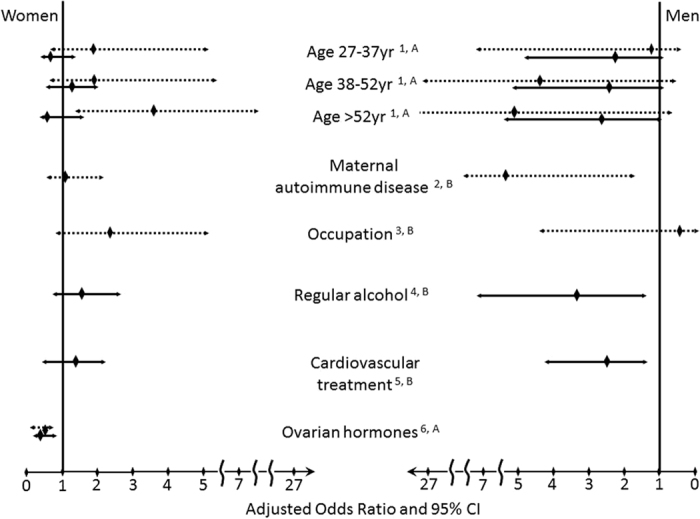
Risk factors for autoantibodies detected in men and women.Autoantibodies against thyroid peroxidase (anti-TPO, dashed line) and any tissue non-specific autoantibody (solid line) groups are shown separately. The tissue non-specific autoantibody group comprised individuals who tested positive for at least one of the 5 tested tissue non-specific autoantibodies. 1age groups were formed according to the values of 1st and 3rd quantiles and the median age compared to the youngest group (18–26 years); 2the presence of maternal autoimmune disease compared to individuals without maternal autoimmune disease; 3individuals with an occupational status of unemployed but being covered by pension insurance (includes retired individuals and unemployed individuals with insurance for disability) compared to employed persons; 4seldom but regular alcohol consumption (once a month) compared to non-consumers; 5the need for cardiovascular treatment on a regular basis at least 2 months prior to the study; 6women with active ovarian hormones includes women who menstruate and women with primary or secondary amenorrhea who receive hormone replacement therapy compared to women in menopause. Association values are given as odds ratios considered for multiple comparisons from multivariate logistic regression models stratified by gender and adjusted for the following confounders selected from Table 5: A age groups; B age groups (or ovarian hormonal activity in women), maternal autoimmune disease, occupational status, alcohol consumption, cardiovascular treatment. CI –confidence interval.